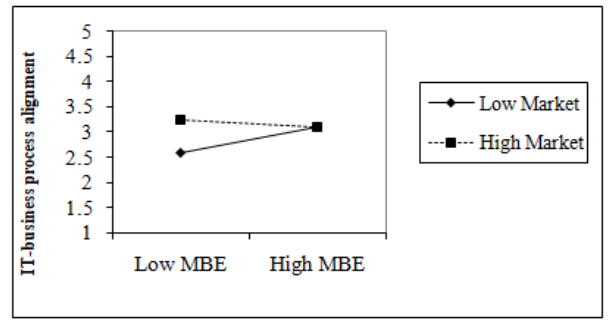
Figure 4. Management by exception * market